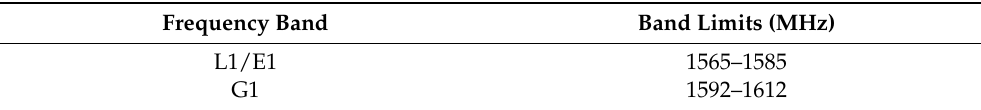
Table 6. Frequency band limits used to analyze event occurrence on GPS/Galileo L1/E1 vs.